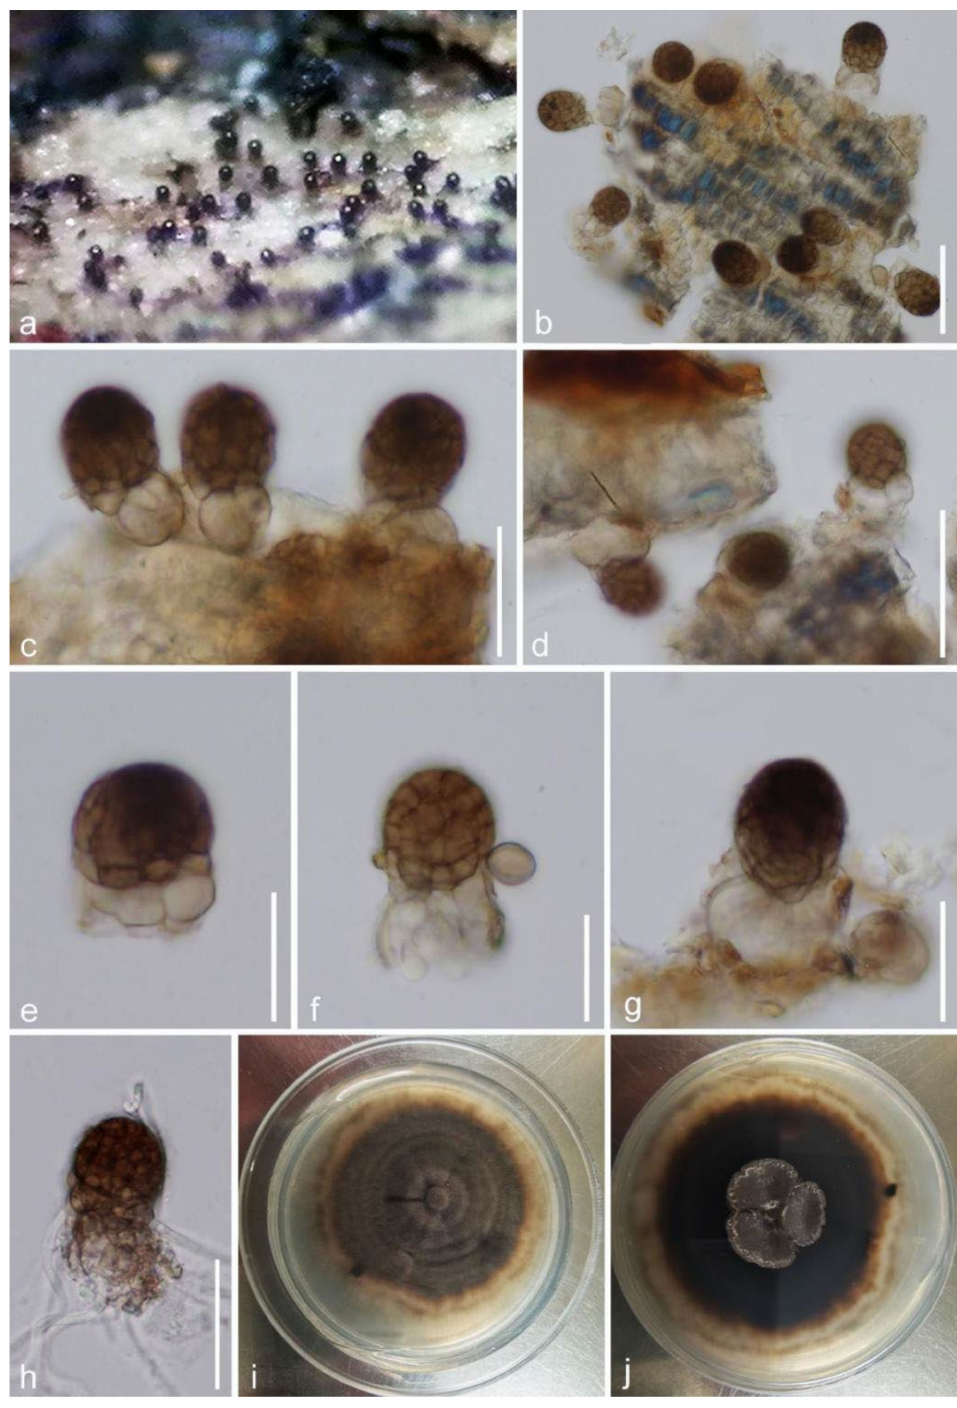
Figure 9. Paramonodictys hongheensis (HKAS 122190, holotype). ( a ) Colonies on surface of bark; ( b – d ) colonies on host surface; ( e – g ) conidia with conidiogenous cells and conidiophore; ( h ) ger- minated conidium; ( i , j ) colony from above and below. Scale bars: ( b , d ) = 50 µ m; ( c , h ) = 30 µ m; ( e – g ) = 20 µ